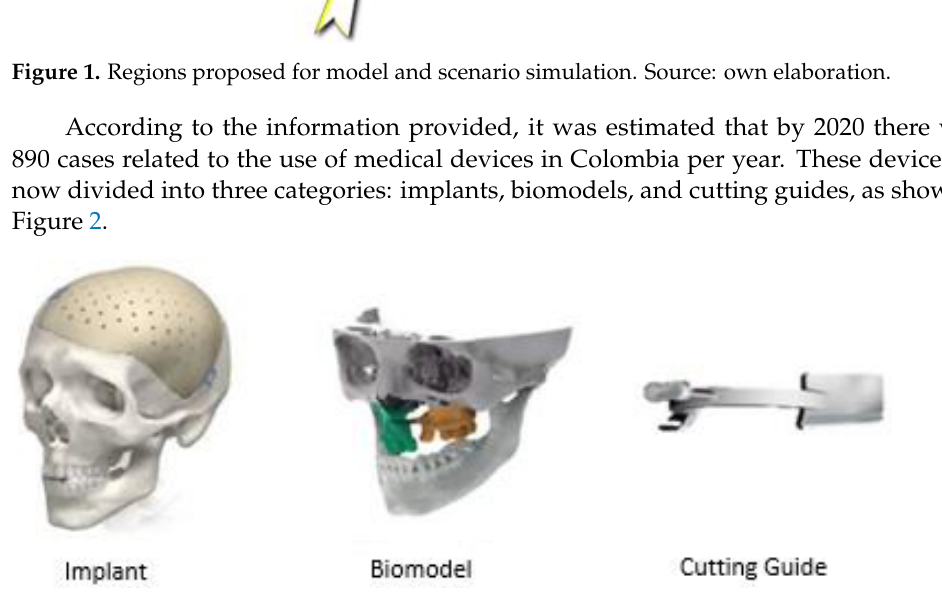
Figure 2. Categories of specific medical devices. Source: Interfaz Research Group and Grice, 2020.